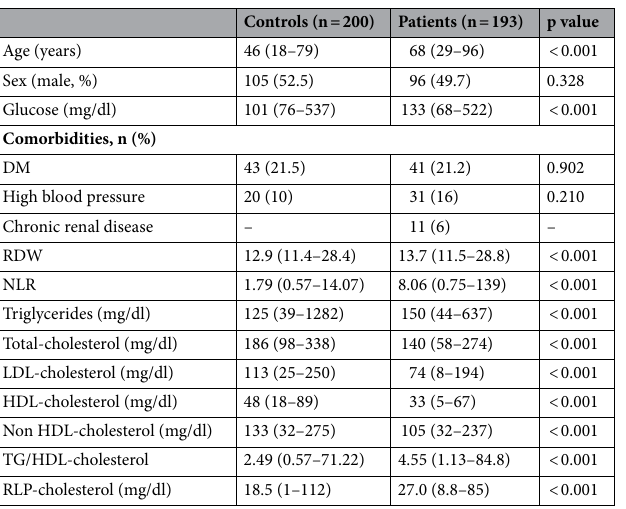
Table 1. Sociodemographic, clinical and biochemical characteristics of the study population. Results expressed as Median (range) or n (percentage) as appropriate. Mann–Whitney and Chi square test. DM diabetes mellitus, RDW red cell volume distribution width, NLR neutrophil-to-lymphocyte ratio, TG triglyceride, RLP remnant lipoprotein.